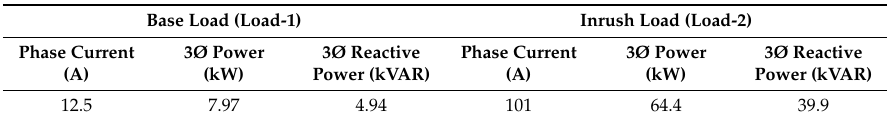
Table 1. Values of the supplied current and the power consumption of the simulated power system for one HT compressor, at 0.85 P.F.